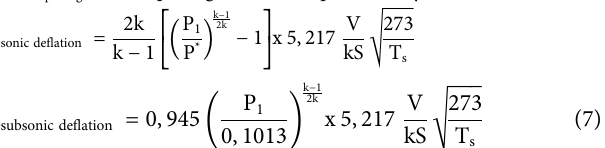
Equation 8 : New alternative calculation of the severity